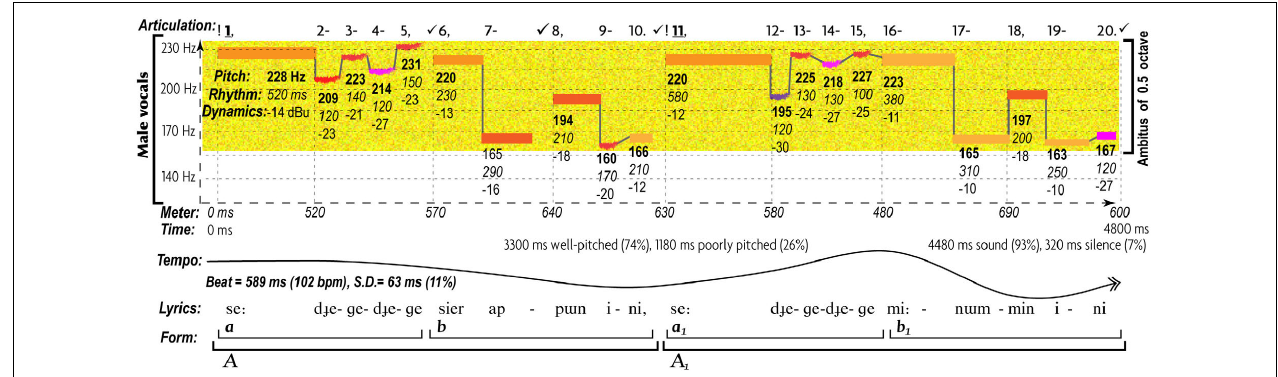
FIGURE 2 | Characteristic patterns of AEs in expression of love in a Yakut traditional lyrical song “Sae Dyige” (may be auditioned at http://chirb.it/sNegG1). By Juslin’s (2005) classification this song fits the “love” music category—in agreement with its lyrics, describing how a woman is anticipating visits of her multiple lovers (Alekseyev and Nikolayeva, 1981, 86). The musogram follows the same conventions as Figure 1 , with minor additions due to the less definite use of pitch in the purely vocal music. Tones of low spectral periodicity (noisy or spoken-like) are represented by fuzzy strips in contrast to high periodicity, represented by rectangular bars. The number under each pitch displays its frequency value in bold, its duration in italic, and its maximal amplitude (the highest value of any of its spectral constituents) in regular font. The lyrics are given in the phonetic transcription. There are two contrasting motifs: “a”—a sustained long anchor tone (tonic function), followed by rapid alternation of steps with rising intonation; and “b” —two descending intonations, the first of which leaps to the alternative anchor (dominant function to mark a cadence), while the second steps down and then gently rises. These two motifs make up a call-like phrase that is regularly repeated. Song is characterized by a narrow ambitus (half-octave), mid-low register, high harmonicity, low complexity, moderate tempo (102 bpm) with little rubato (11%), diverse rhythm (usage of four rhythmic values), regular meter, overwhelming legato (97%), and scarce dynamic changes. For more detailed discussion, see Appendix 2 “A Comparative Structural Analysis of Musograms.”